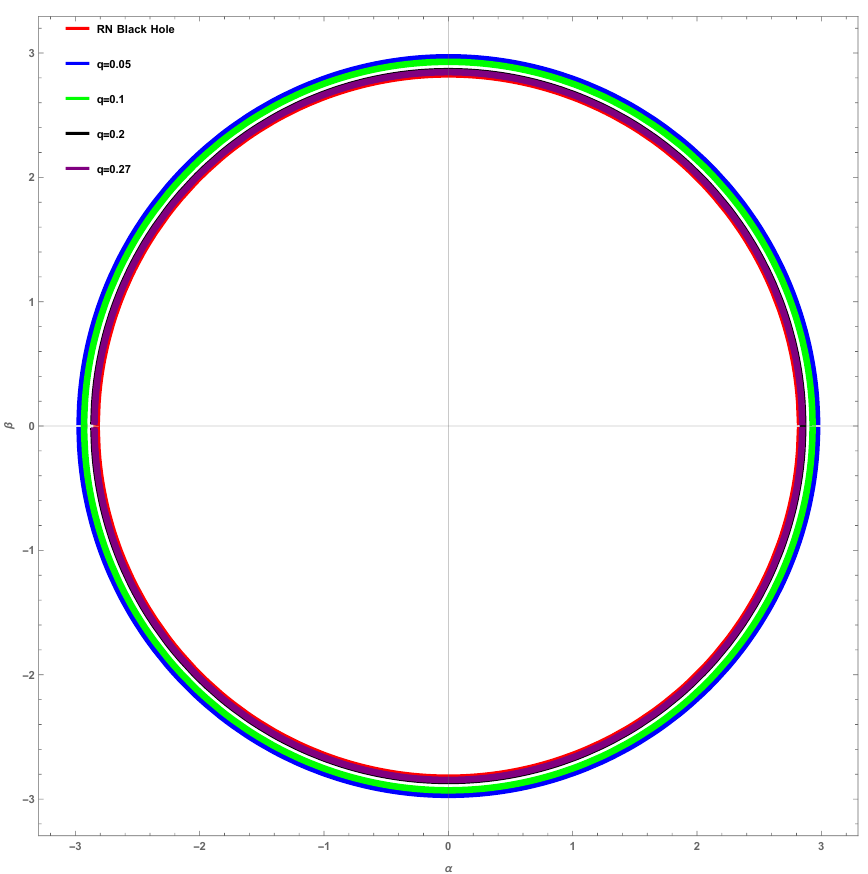
Figure 4. Shadow of the black hole for different values of q for M p = 1, M 5 = 0.5, M =